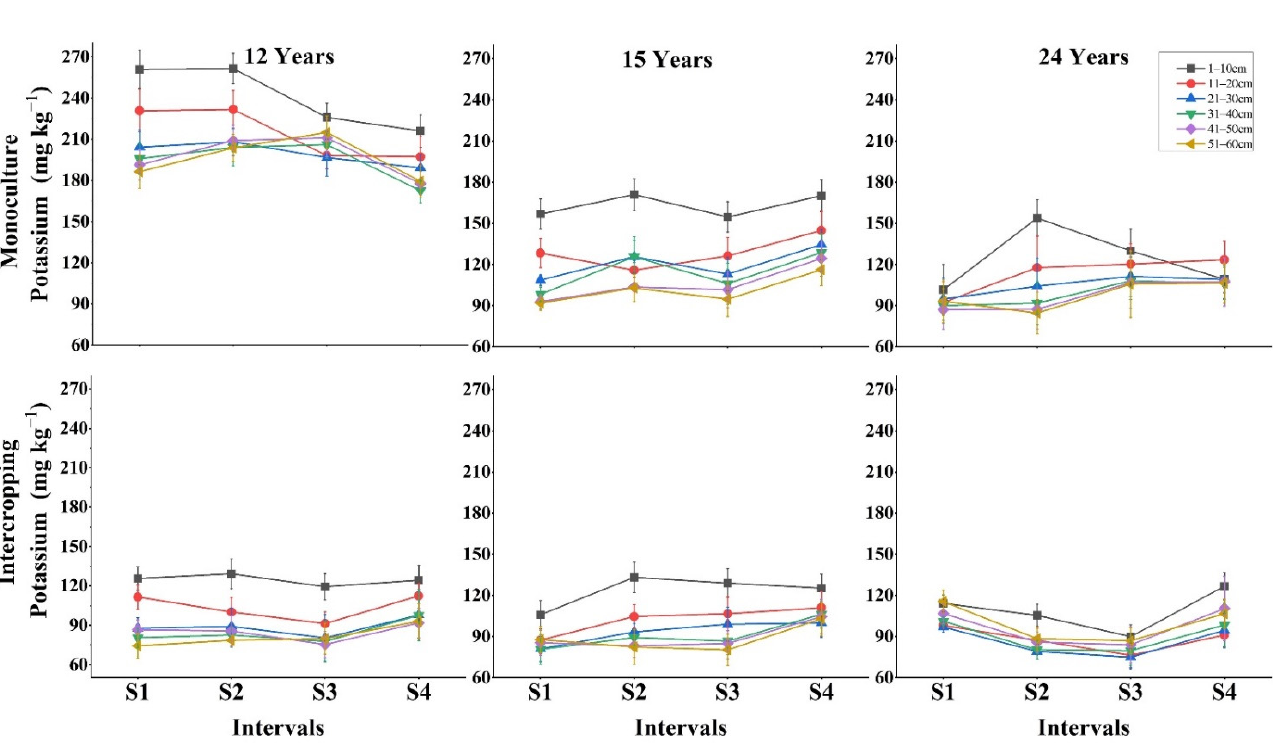
Figure 3. Soil available P in different soil layers across four sampling intervals (S1, June 2018; S2, September 2018; S3, December 2018; S4, March 2019) within different-aged stands of two plantation management types (rubber monoculture versus rubber–F. macrophylla intercropping).